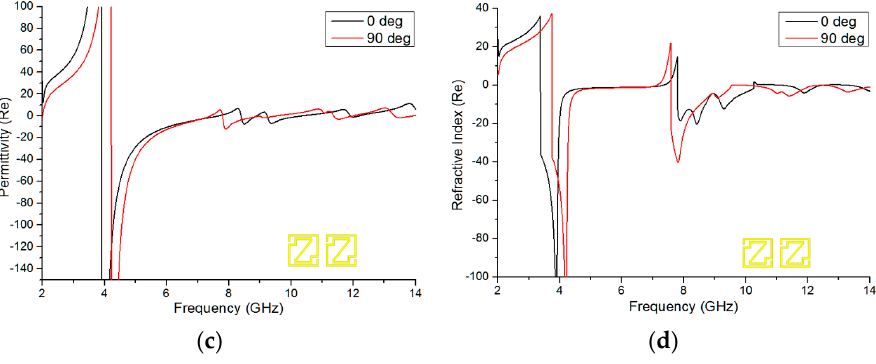
Figure 7. ( a ) 0-degree position of the 1 × 1 array geometry; real magnitude of ( b ) the effective permeability; ( c ) the effective permittivity; and ( d ) the effective refractive index at 0-degree and 90-degree rotations of the 1 × 1 array configuration.